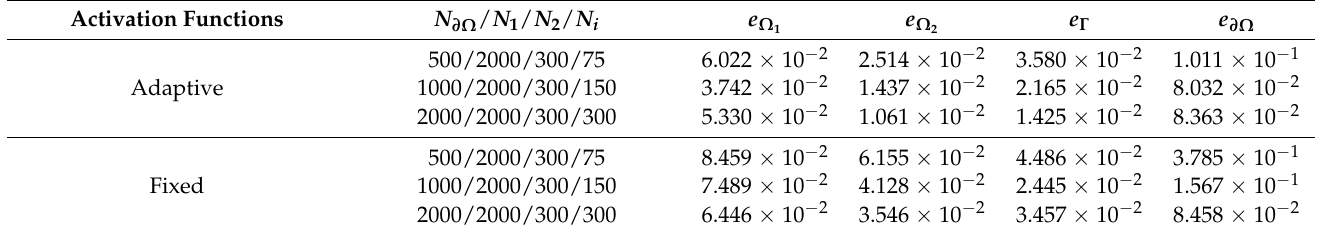
Figure 23. The plot of L s average error loss for Example 7. Table 13. Comparison of errors by adaptive and fixed activation function strategies with different numbers of training points for Example